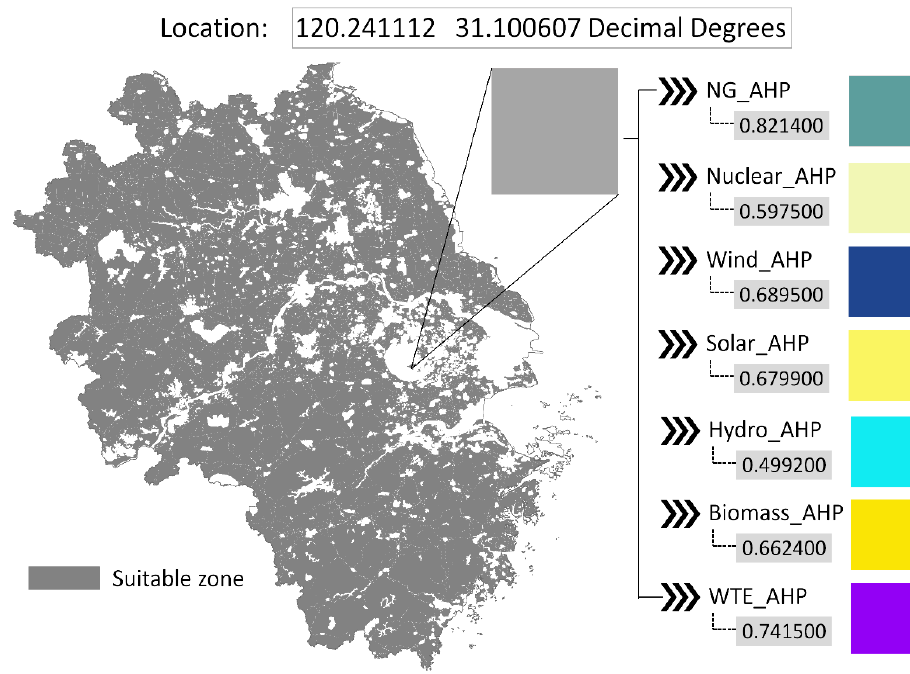
Figure 8. Spatial siting potential of alternative power plants in one cell.